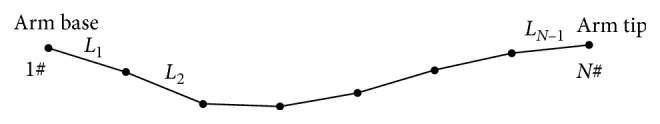
The actuator model.